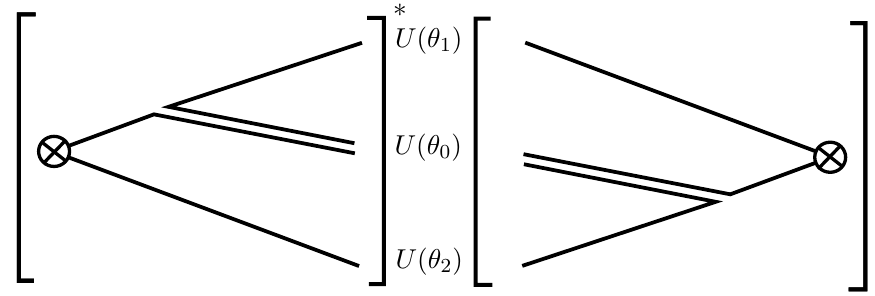
Figure 1 . Soft wide-angle radiation: radiation is allowed in some region but excluded in another. To keep track of the allowed radiation we use a color density matrix, de(cid:12)ned by applying an angle- dependent color rotation U ( (cid:18) i ) between the matrix element and its conjugate for each (cid:12)nal state particle. In the planar limit this con(cid:12)guration reduces to a product of two color